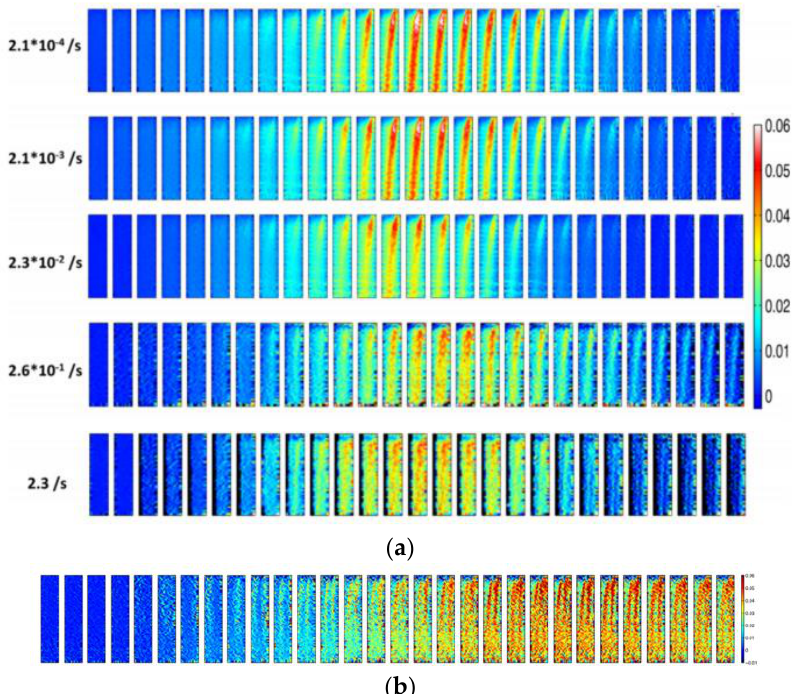
Figure 6. ( a ) Shear strain contours with shear bands evolutions at five different strain rates from 10 −4 s −1 to 10 1 s −1 ; ( b ) separated bands at a strain rate of 10 2 s −1 [34]. (Adapted from Ref. [34], Figs. 10 and 18, 2017, with permission from